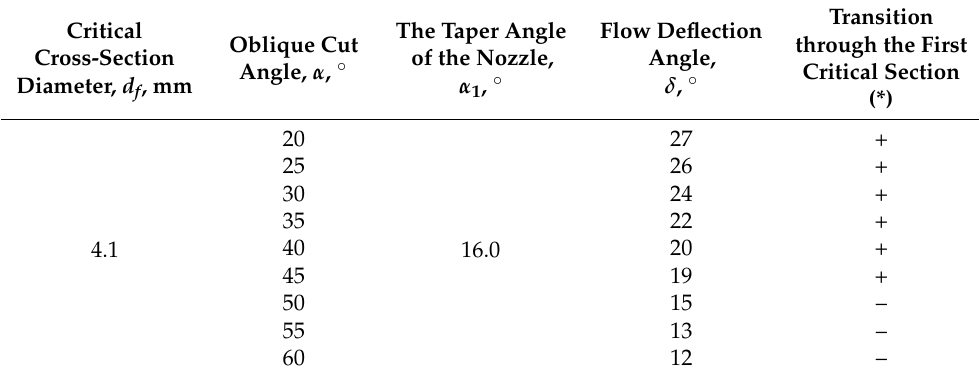
Table 2. The results of the numerical calculations for the active flow